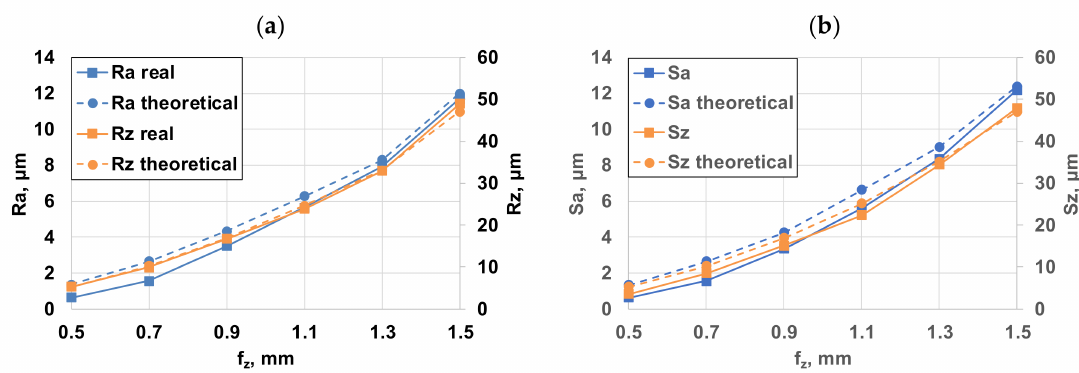
Figure 6. The roughness results of single-insert face milling: ( a ) 2D roughness parameters; ( b ) 3D roughness